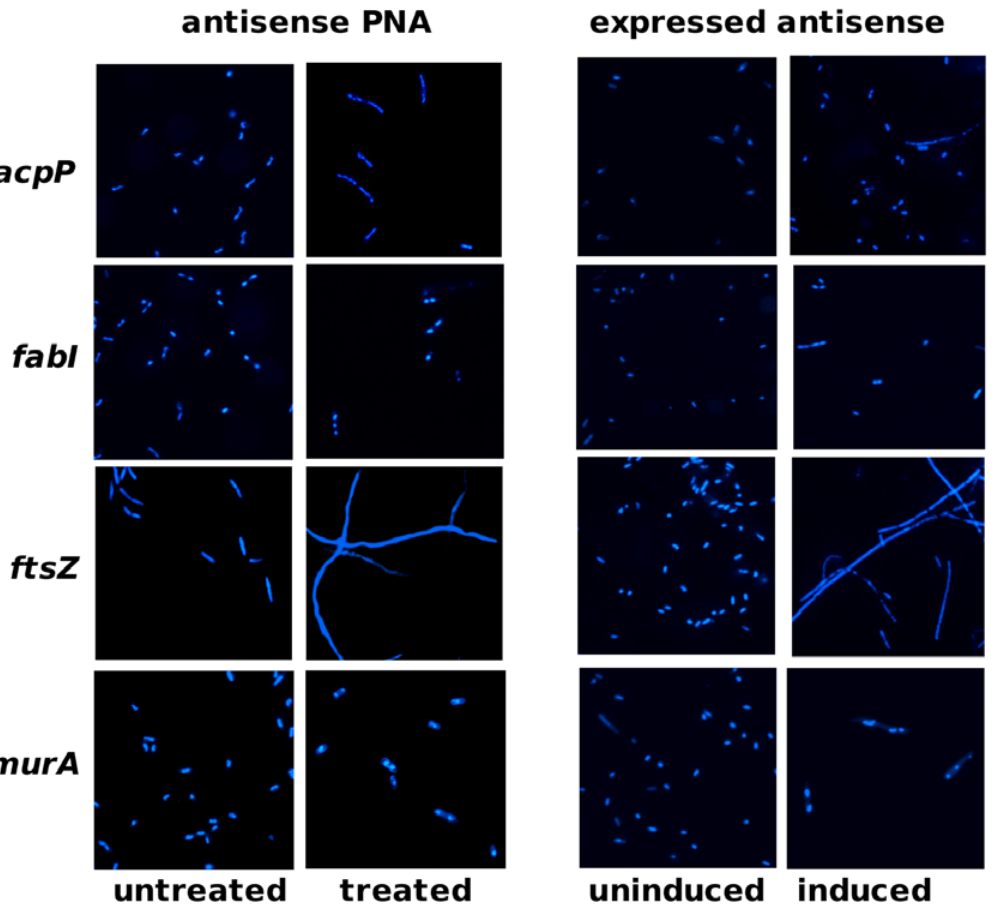
Figure 4. Effect of gene silencers on cell morphology. Cells were stained with DAPI before fluorescent microscopy. Left panel: AS19 untreated or treated with antisense PNA Ec108 (20 nM) targeting acpP , Ec107 (80 nM) targeting fabI , Ec326 (70 nM) targeting ftsZ or Ec330 (55 nM) targeting murA . Gross elongation of cells was observed only in cultures treated with ftsZ -specific PNA, Ec326. Right panel: TOP10 clones uninduced or induced with IPTG for antisense RNA expression. Concentrations of IPTG used for induction of acpP -, fabI -, ftsZ - and murA -antisense expression were 160 m M, 130 m M, 80 m M and 80 m M, respectively. Cells expressing ftsZ -antisense were grossly elongated compared to other cells.